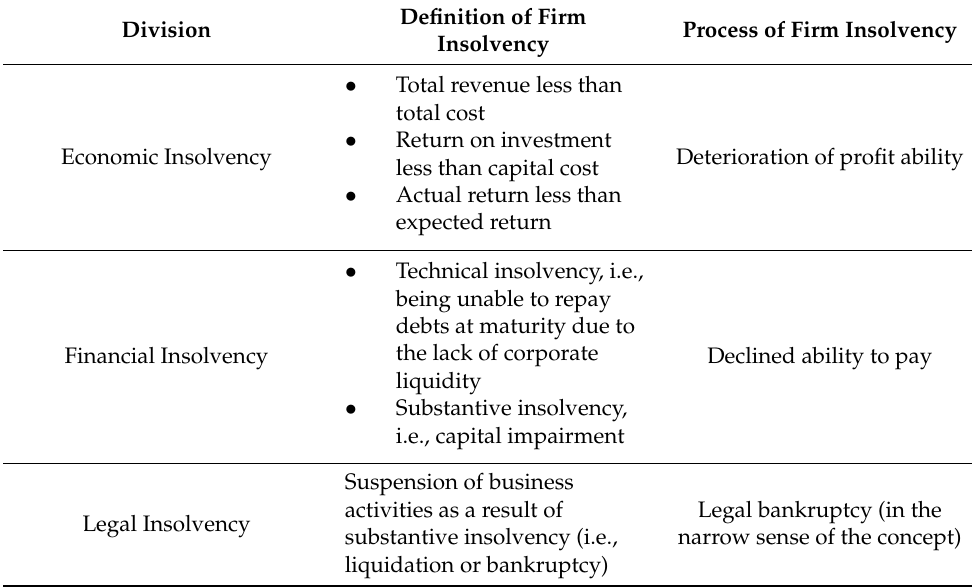
Table 1. The concept of firm